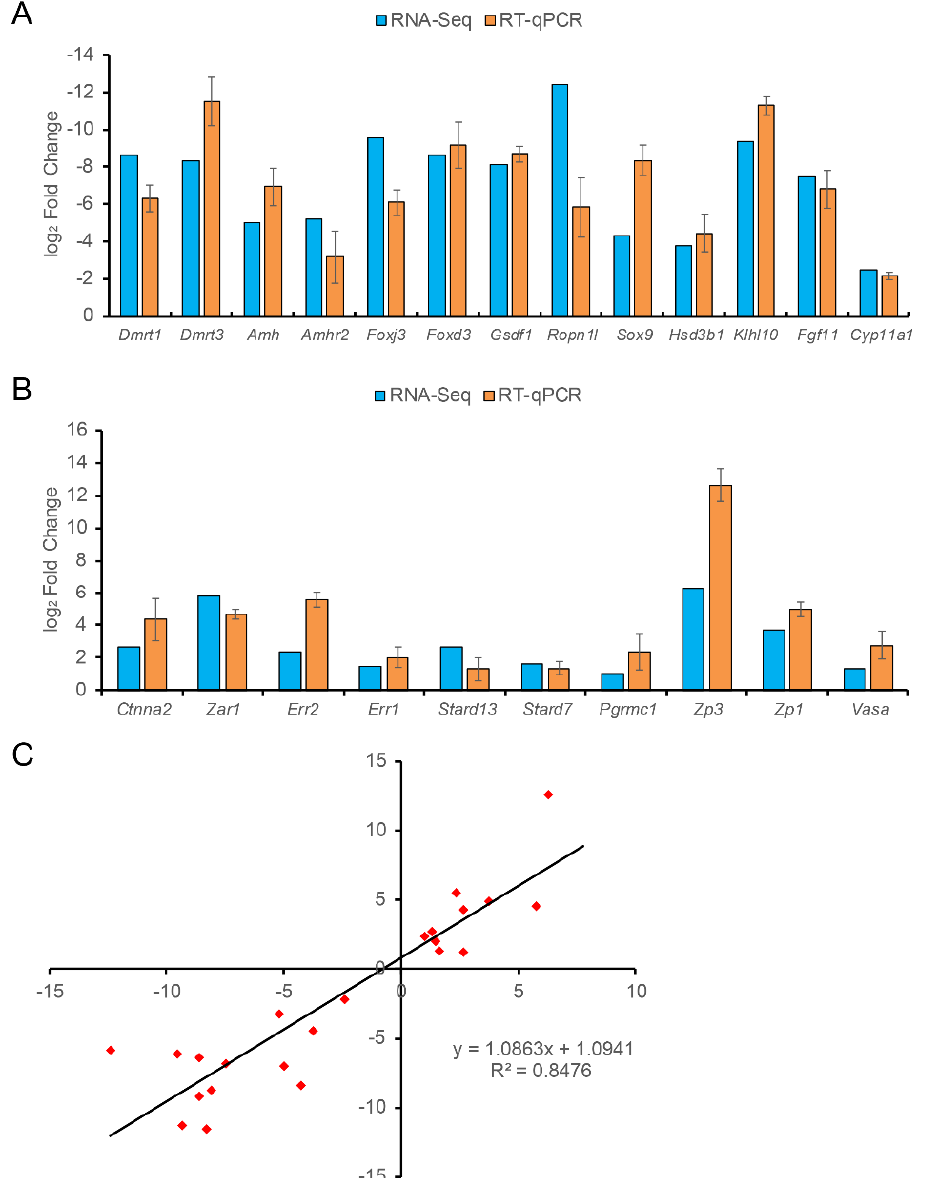
Figure 5. Verification of expression profiles of 13 testis-biased ( A ) and 10 ovary-biased genes ( B ) using RT-qPCR. ( C ) Correlation analysis of the RNA-Seq data and RT-qPCR results.